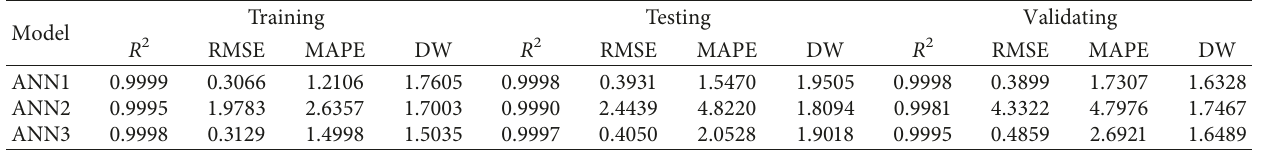
Figure 14: Correlation between water permeability and porosity of VS-based concretes. Table 3: Results obtained for ANN models.